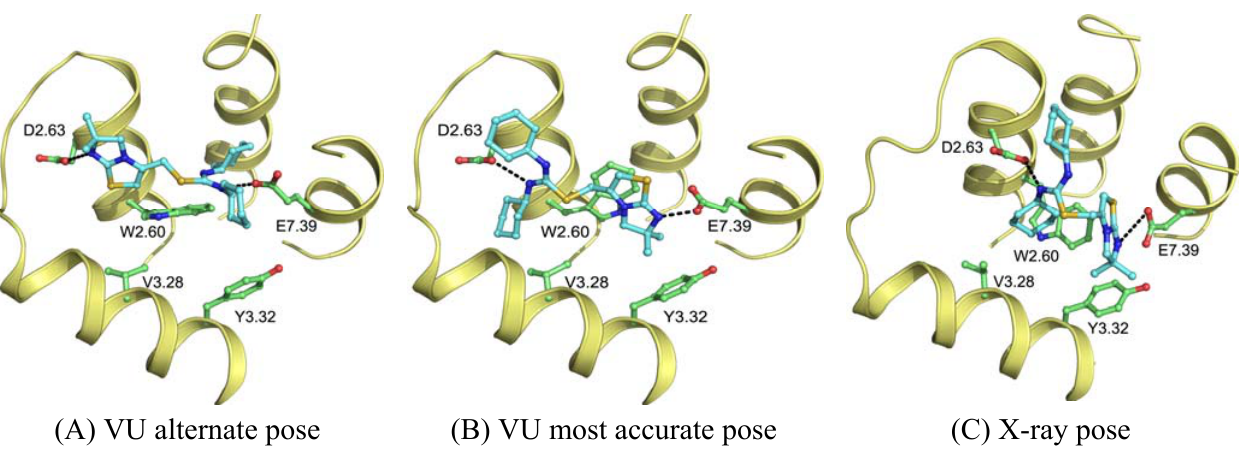
Figure 7. Binding poses as predicted by VU-MedChem using GOLD compared to the X-ray